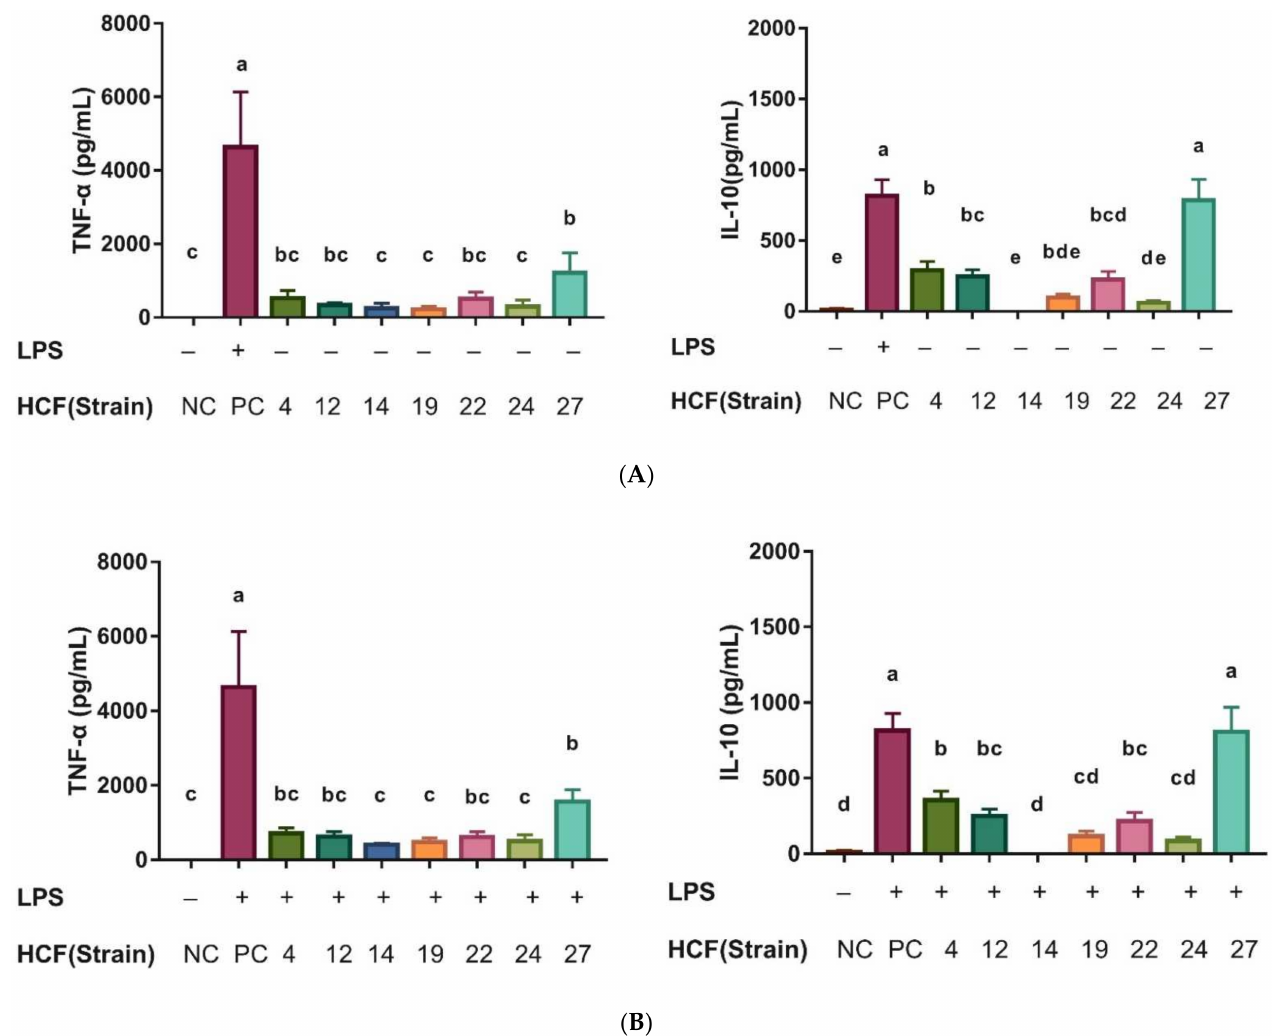
Figure 6. Effect of isolated bacteria strains in the secretion of ( A ) TNF- α and ( B ) IL-10 with or without LPS stimulation as co-cultured with RAW 264.7. Data were expressed with means ± SD ( n = 3). + and − symbol represent with and without LPS addition, respectively. a,b,c Means for each group determined by a different superscript letter were significantly different analyzed by ANOVA with Tukey’s range test ( p < 0.05). NC: negative control; PC: positive control; HCF (strain) 4-27: B. longum subsp. longum